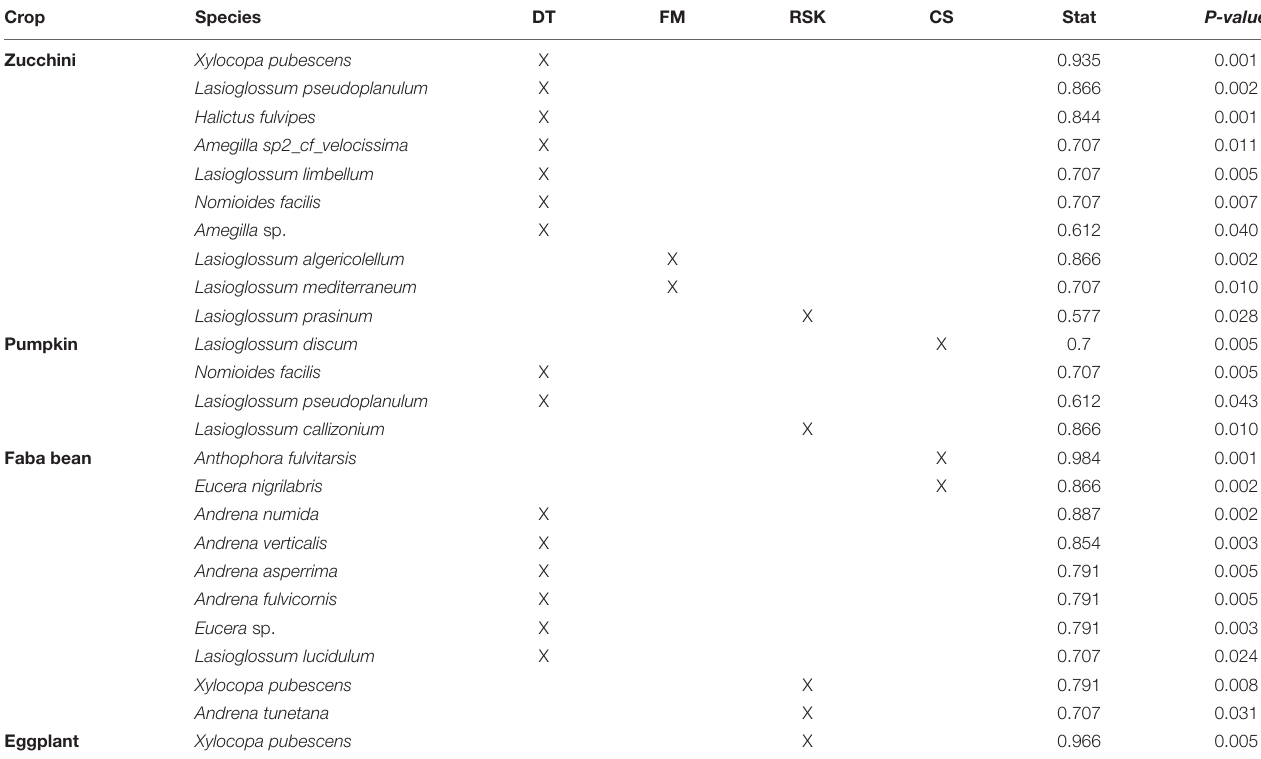
TABLE 1 | Indicator bee species visiting crops significantly associated with only one region (DT, Draa-Tafilalet; FM, Fes-Mekenes; CS, Casablanca-Settat; RSK, Rabat-Sale-Kenitra). Crop Species